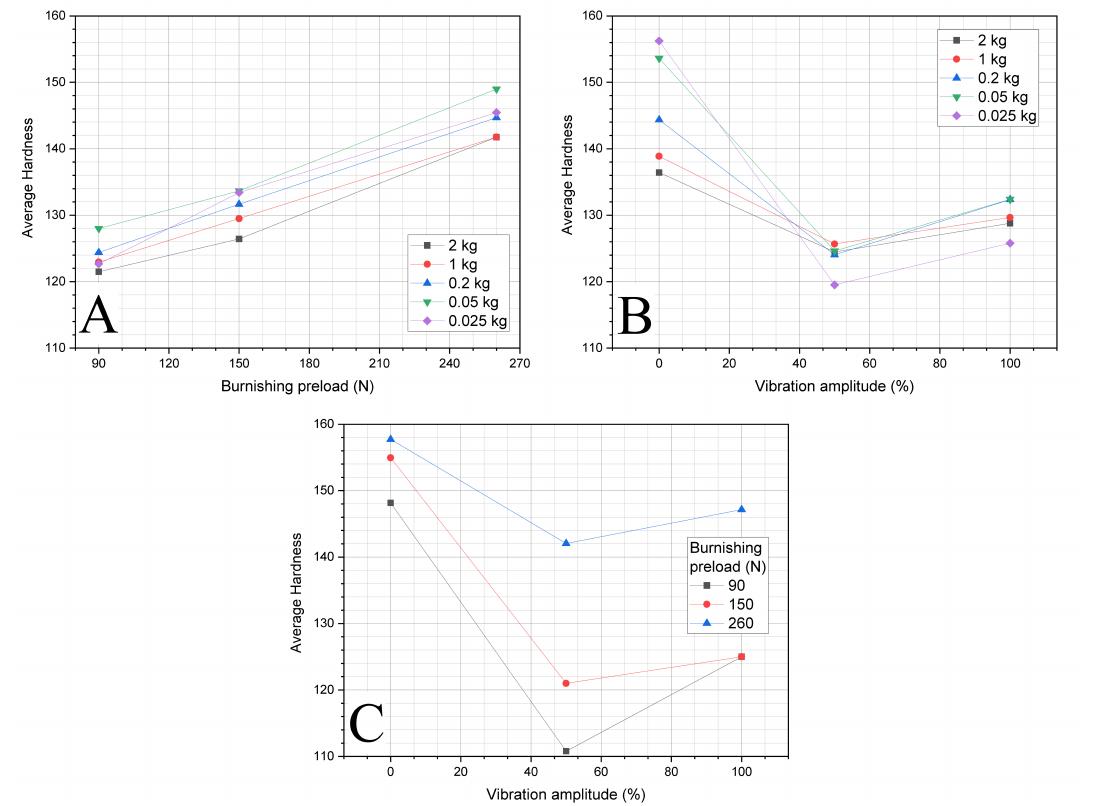
Figure 6. Main effects graphs. Response variable: Vickers hardness. ( A ) Effect of burnishing preload. ( B ) Effect of vibration amplitude. ( C ) Effect of the interaction between the preload and